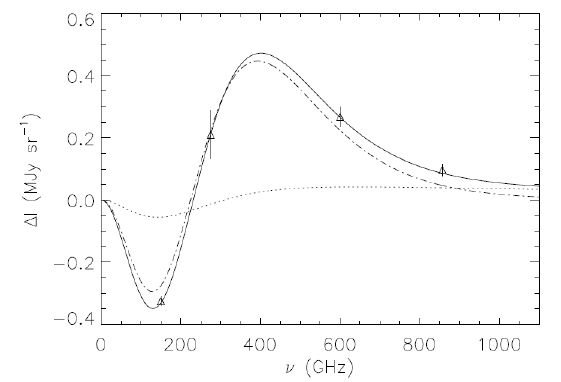
Figure 2: The SZE spectrum at the Bullet cluster center modeled with a thermal plus nonthermal plasma: thermal plasma with kT = 13 . 9 keV and τ = 1 . 1 × 10 − 2 (dot-dashed); nonthermal plasma with p 1 = 1, s = 2 . 7 and τ = 2 . 3 × 10 − 4 (dotted); total SZE produced by the sum of the two plasmas (solid).